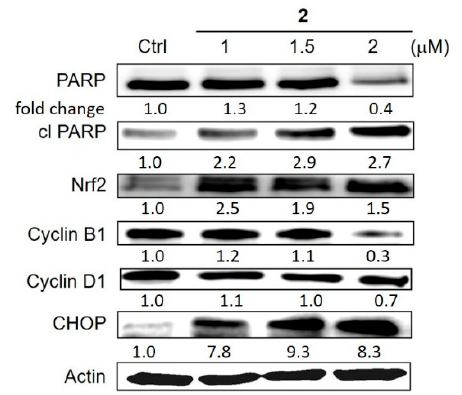
Figure 9. Western blot analysis of various proteins involved in apoptosis (PARP and cleaved PARP), cell cycle (cyclins B1 and D1), antioxidant defence (Nrf2) and ER stress (UPR) presented as a fold change in comparison with untreated cells and normalised to actin as a loading control (one representative strip is shown). A2780 cells were treated with indicated concentrations of 2 for 24 h. Total lysates were isolated and examined by Western Blotting. The quantification of the bands was performed in Image J software.